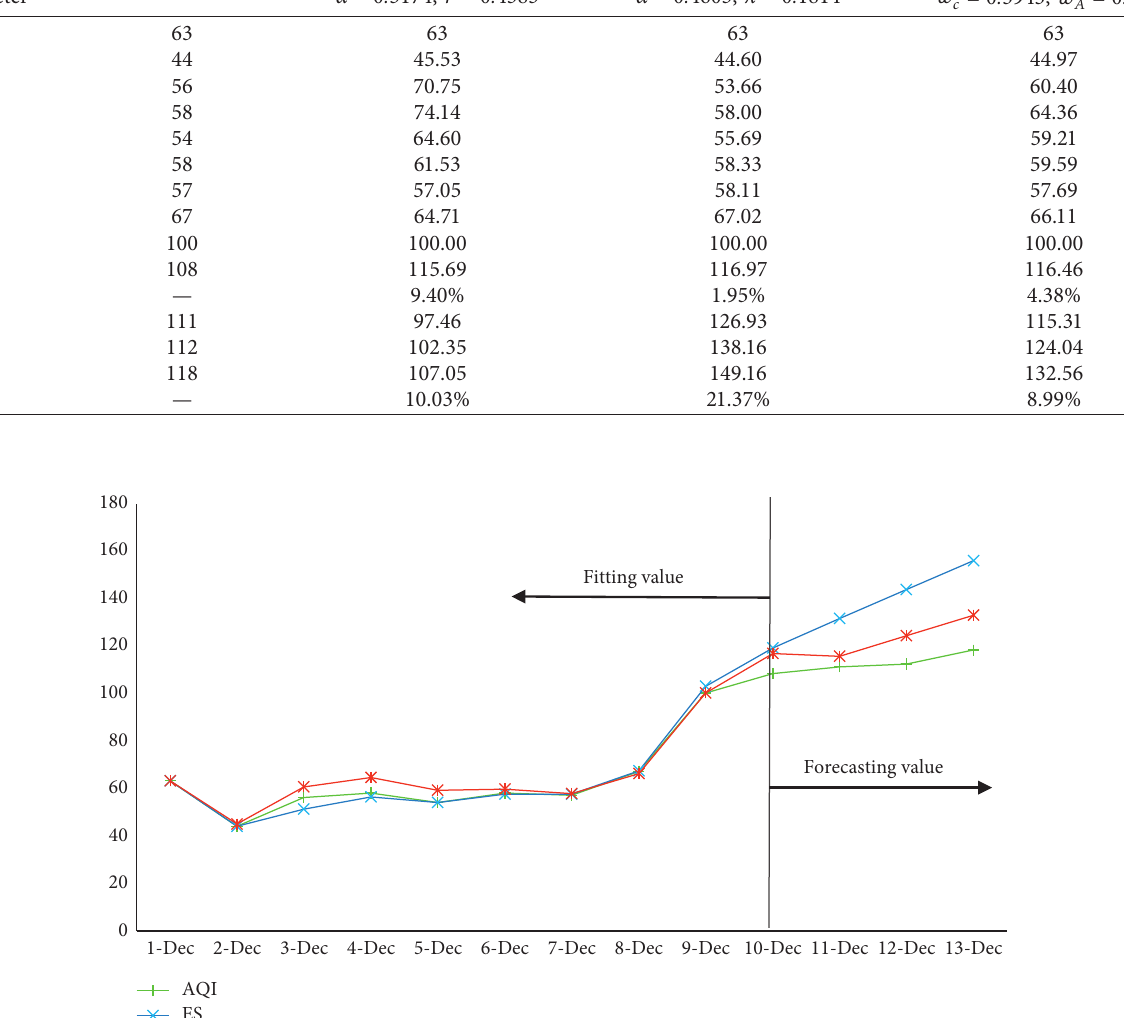
Figure 3: Compared forecasting results between hybrid model and